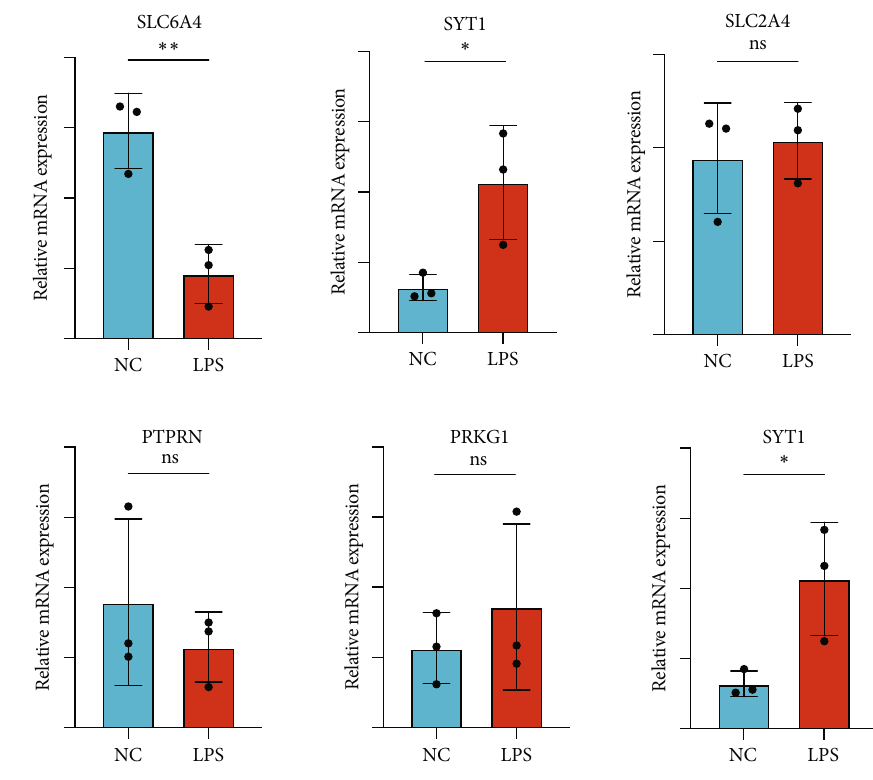
Figure 8: Validation of the expression of hub genes in SVOG. Table 4: The primer sequences of hub genes.